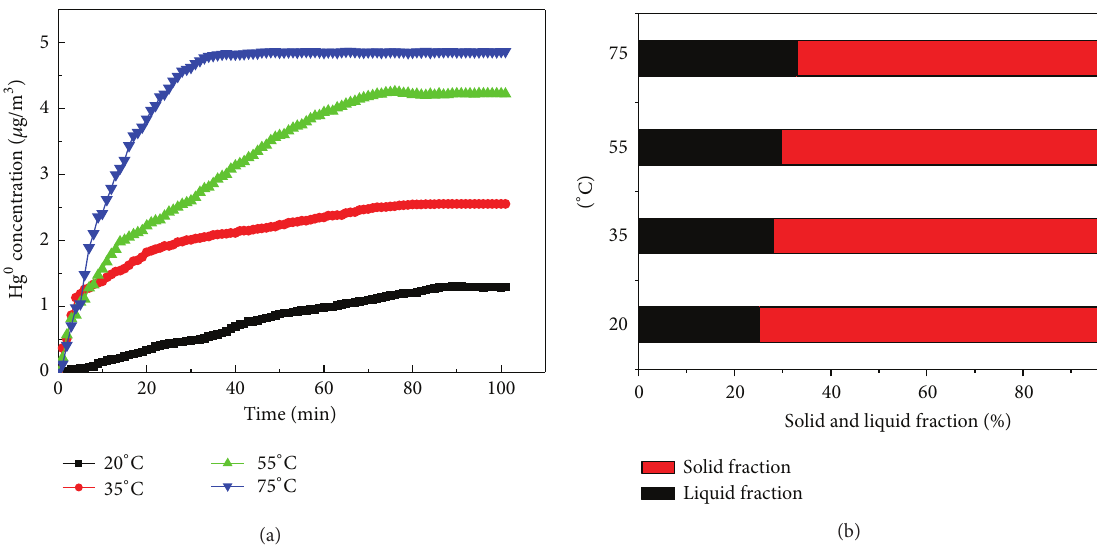
Figure 3: (a) Effect of the temperature on Hg 0 reemission. (b) Relationship between the proportion of mercury retained in the solid and liquid fraction of the slurry and the temperature.